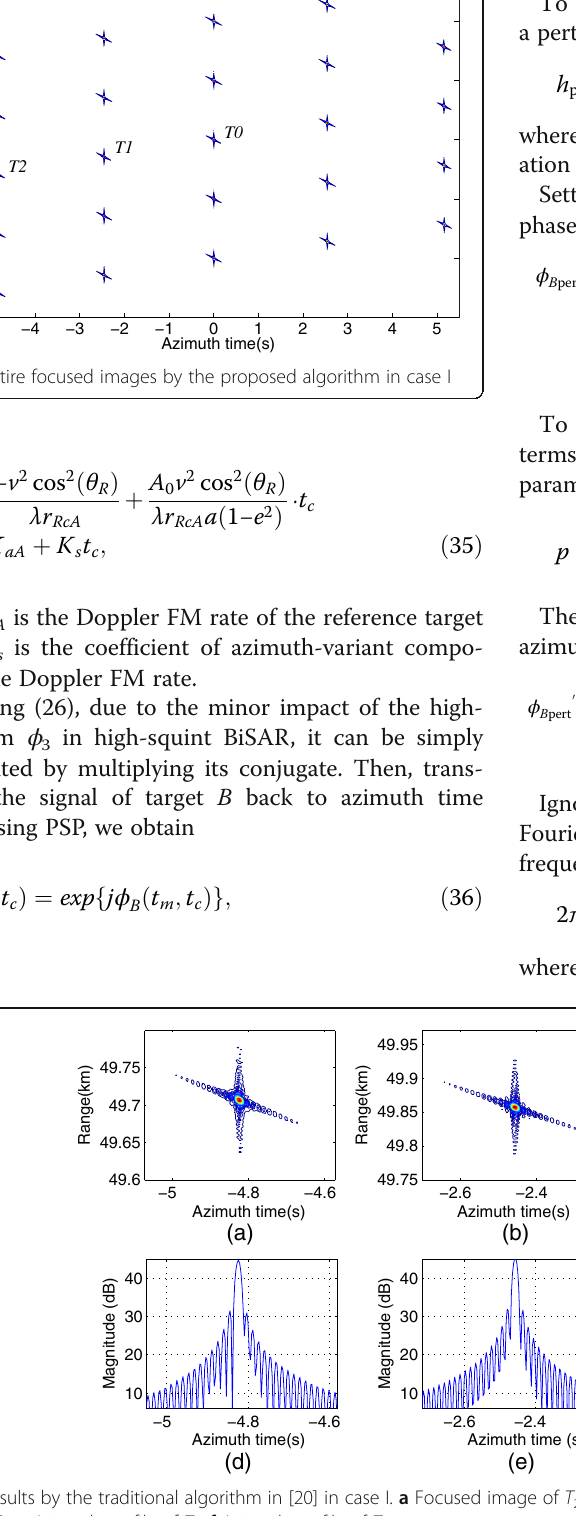
To equalize the Doppler FM rates of targets A and B ,